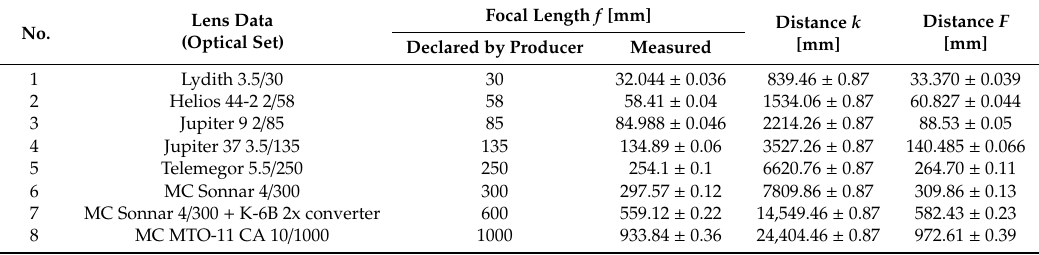
Table 1. Technical data of measurement devices for checking the influence of lens focal length and measurement distance for uncertainty of measuring the position of the object image on the camera